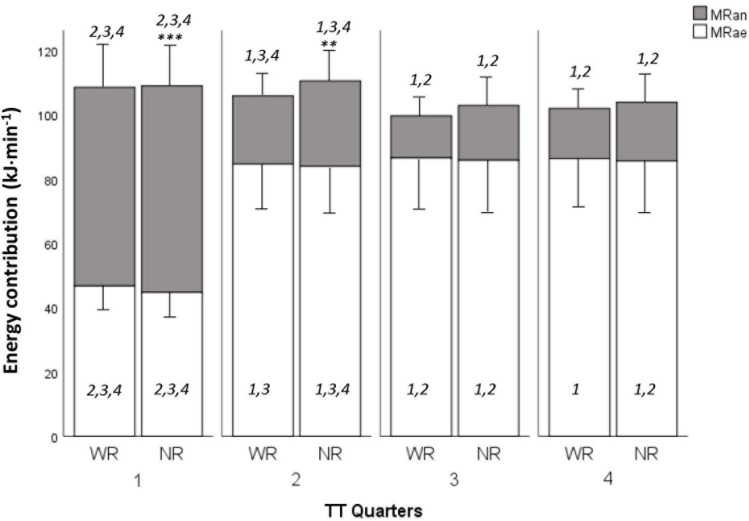
Aerobic (MRae) and anaerobic (MRan) energy contributions for each quarter (1–4) of the maximal time trial (TT: 225 m each for females, 250 m each for males) when skiing with (WR) and without (NR) the rifle. Different from NR: ∗∗p < 0.01, ∗∗∗p < 0.001. Numbers indicate a difference from other quarters for the same condition (WR/NR), P < 0.05.